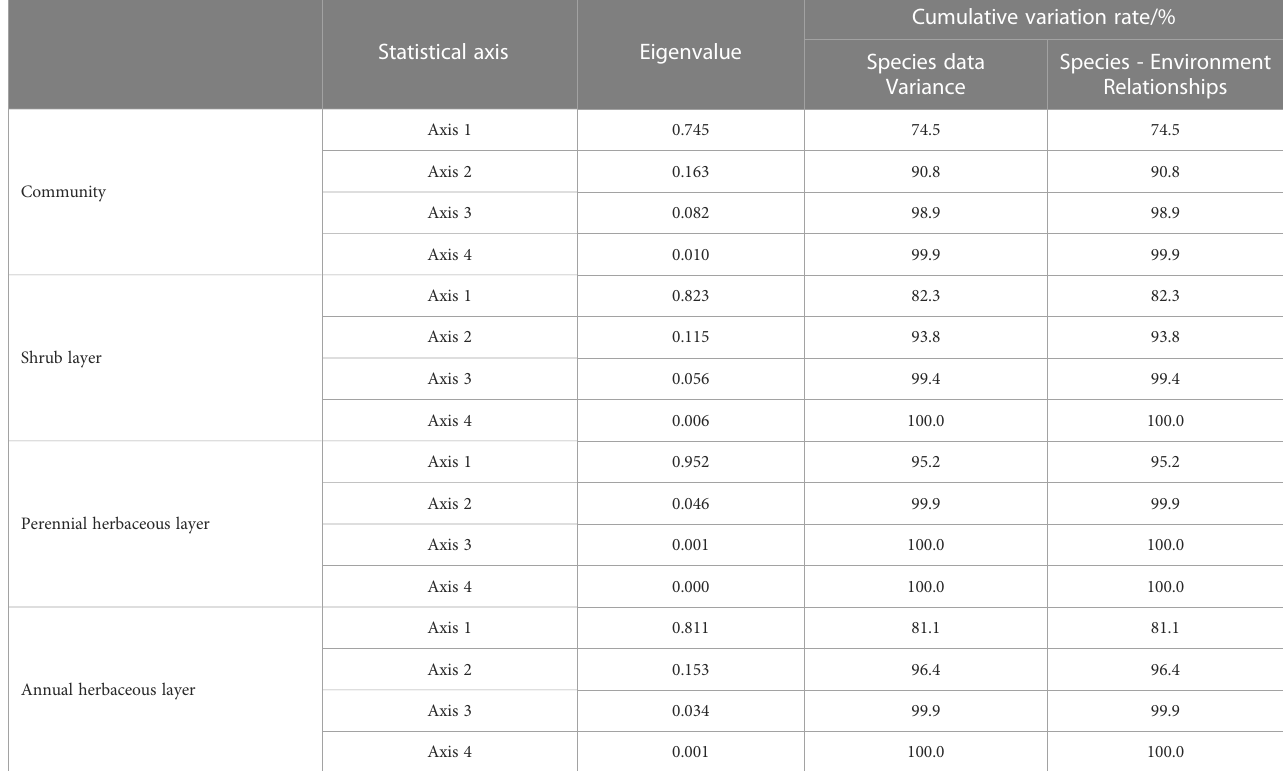
Cumulative variation rate/% Species data